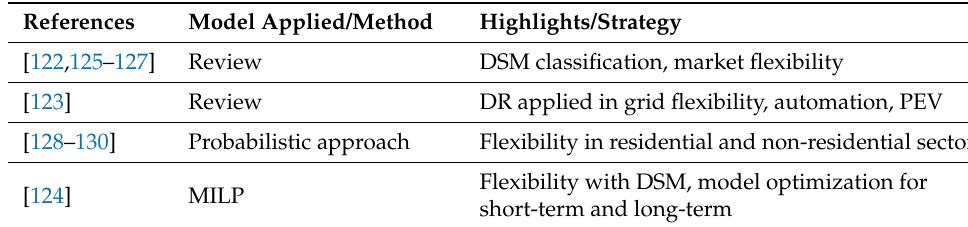
Table 2. Highlights of flexibility approach based on